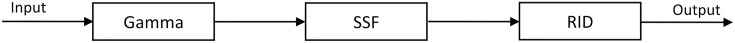
Flow chart of our proposed algorithm.A degraded image is enhanced through three steps in sequence: Gamma manipulation (Gamma), self-similarity filtering (SSF) and robust inverse diffusion (RID), respectively.